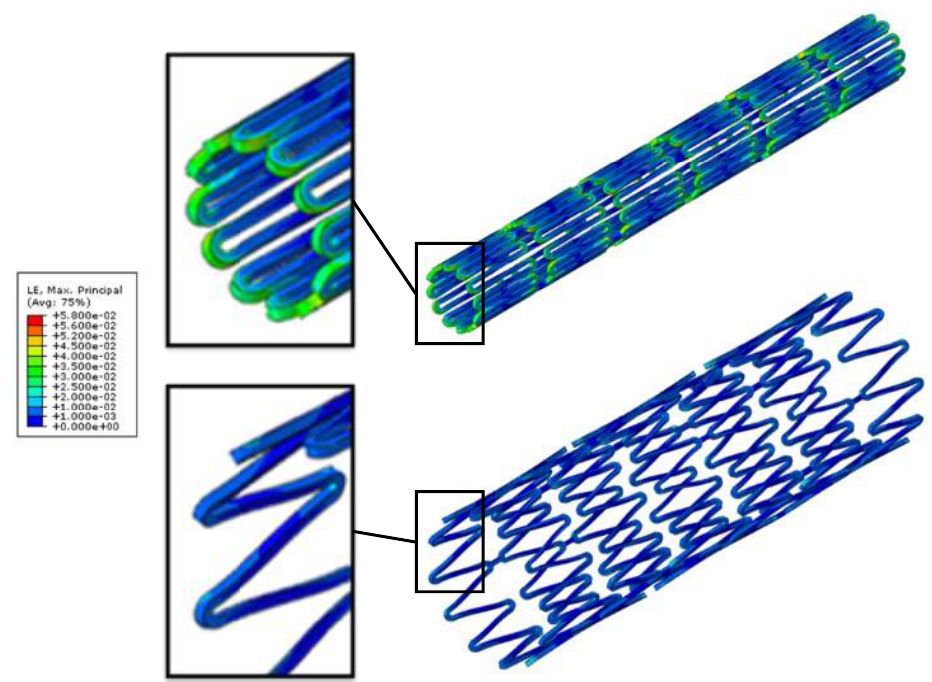
Figure 8. Contour plot comparison of strain distribution at crimping ( top ) and deployment ( bottom ) for the standard design. Table 1. Maximum strains and fatigue safety factor as a function of the strut tapered